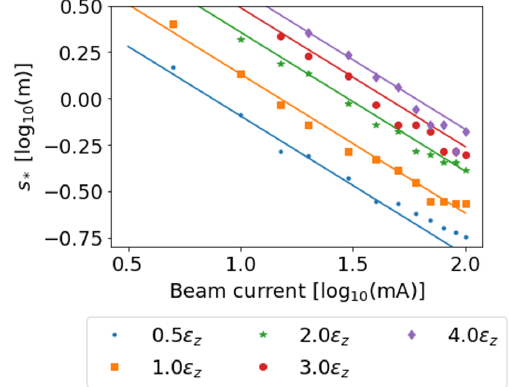
FIG. 6. Dependence of crossover point s (cid:3) on average beam current for four different emittance values, where ϵ ¼ 50 deg keV. The solid lines are defined by s z